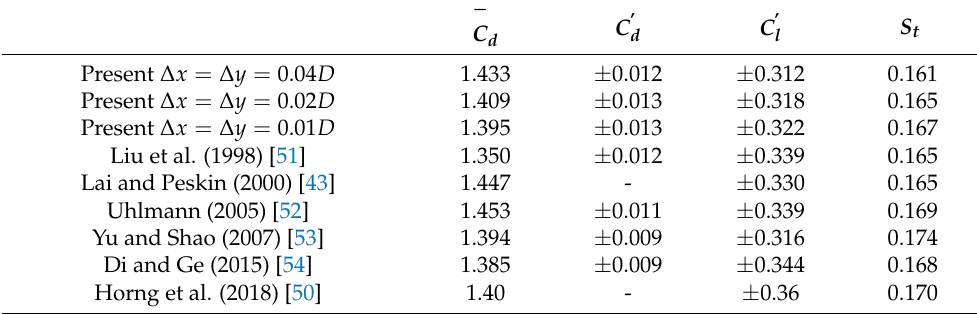
Figure 5. Vorticity contours of the flow around the circular cylinder for Re = 100. Table 2. Comparison of drag and lift coefficients, and Strouhal number of flow past the cylinder for Re =